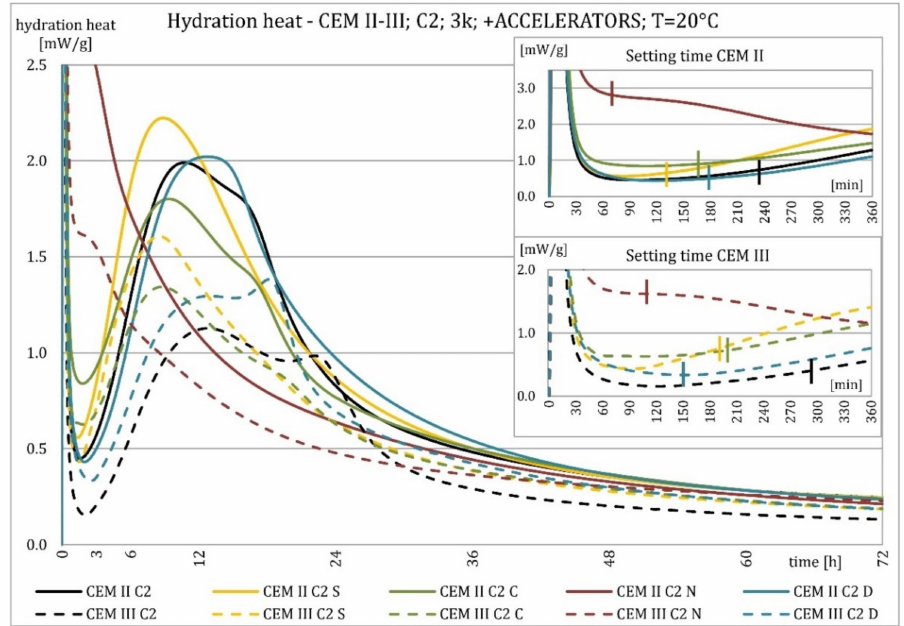
Figure 22. Hydration heat of C2 clinker-based cements CEM II/B-S, CEM III/A modified with accelerators at 20 ◦ C.